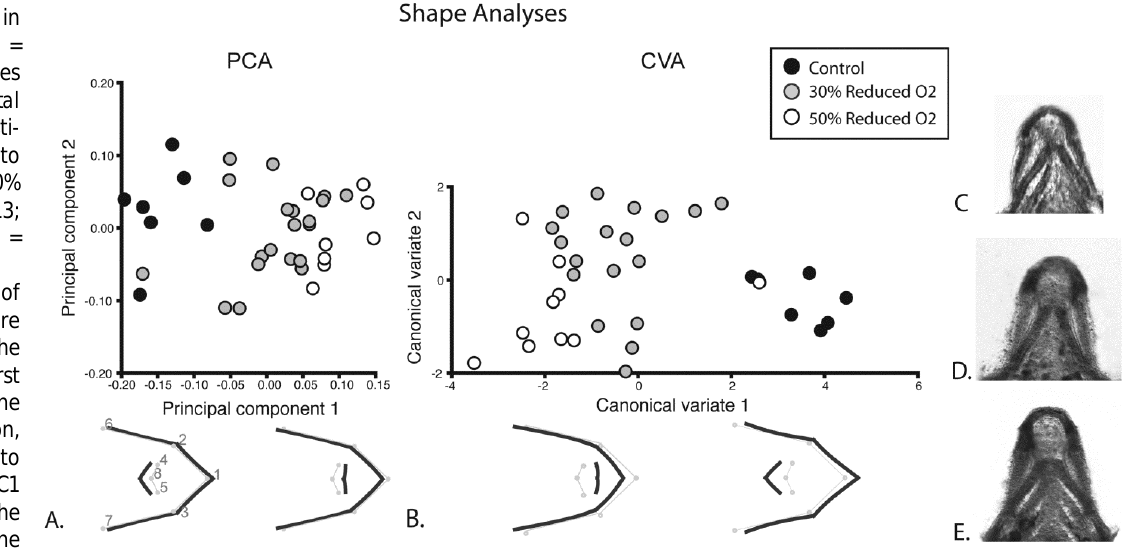
Figure 2 : Shape analysis